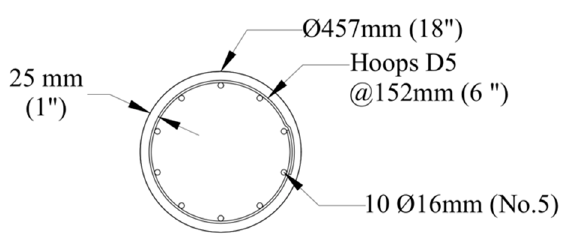
Figure 10. Cross-section of the reinforced concrete (RC) column model.